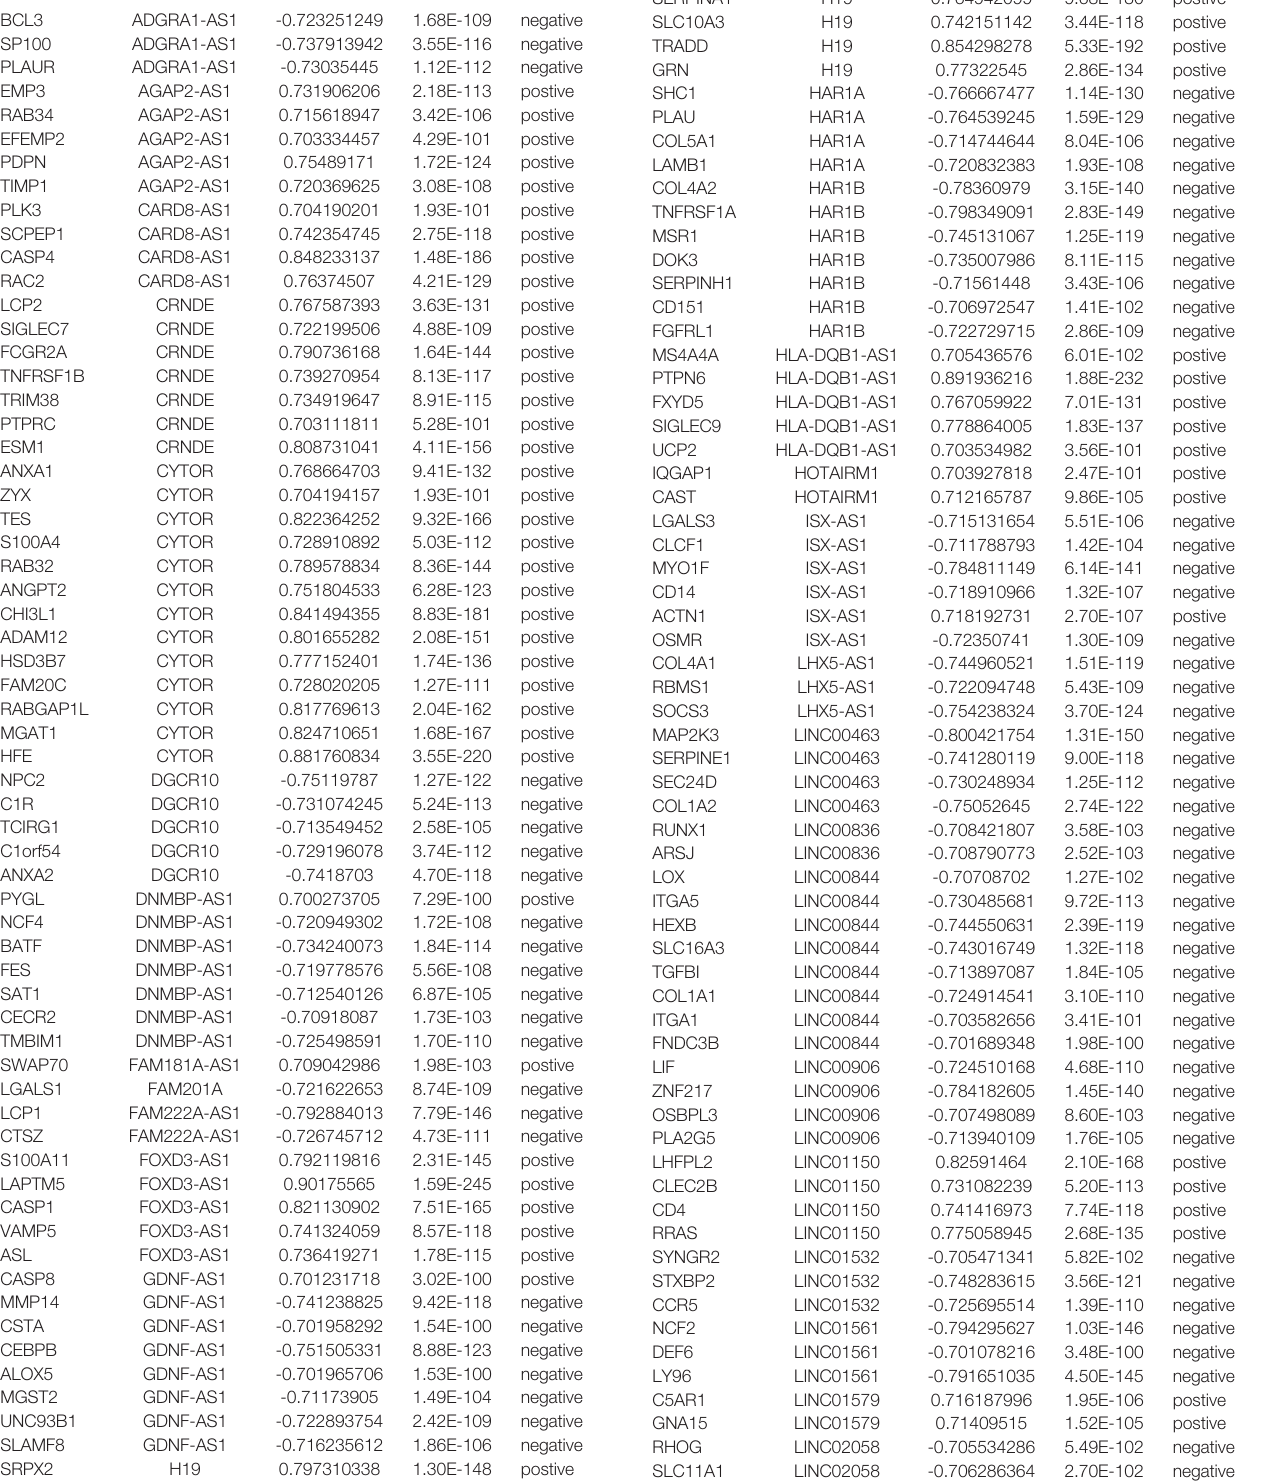
TABLE 2 | Correlation between the MES-related lncRNAs and MES-related genes in glioma.